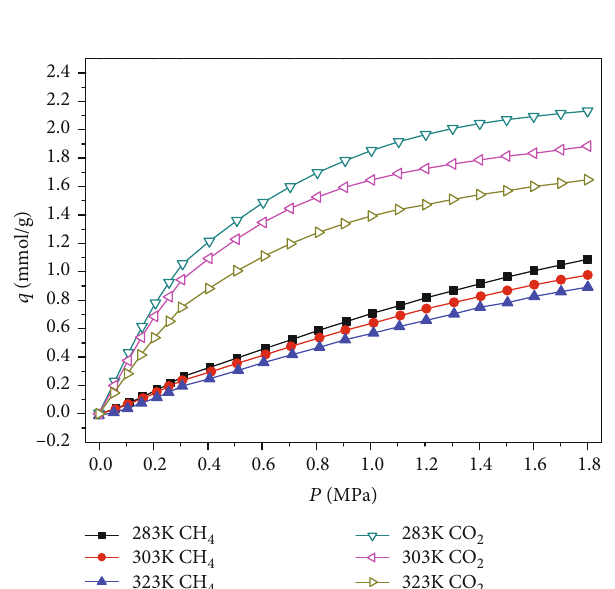
Figure 3: Adsorption isotherms of CO temperatures on